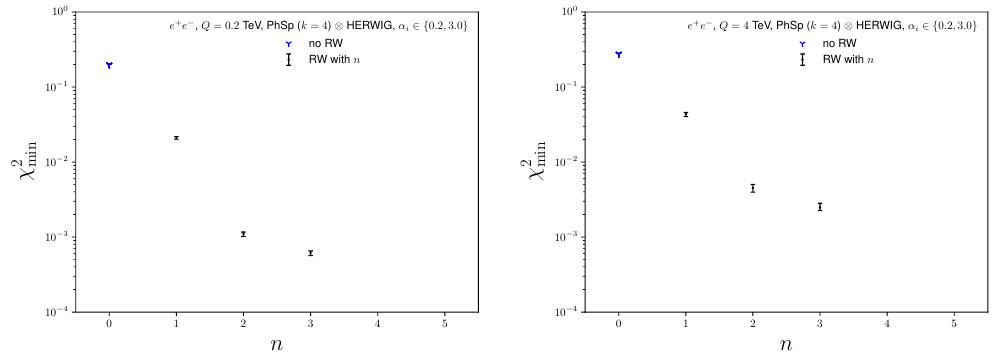
Figure 11 . Same as the right panel of (cid:12)gure 7 but for Q = 200 GeV (left panel) or Q = 4 TeV (right panel). In this case, n = 4 ; 5 are not